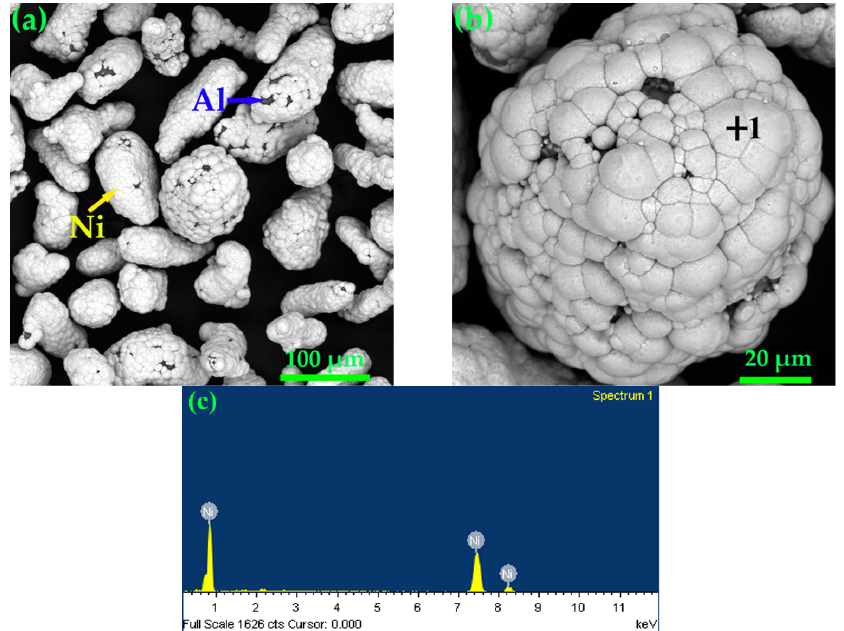
Figure 1. The surface morphologies of Ni-coated Al powder at ( a ) 500× and ( b ) 2000×, and ( c ) EDS analysis of the Ni coating on the Al powder.